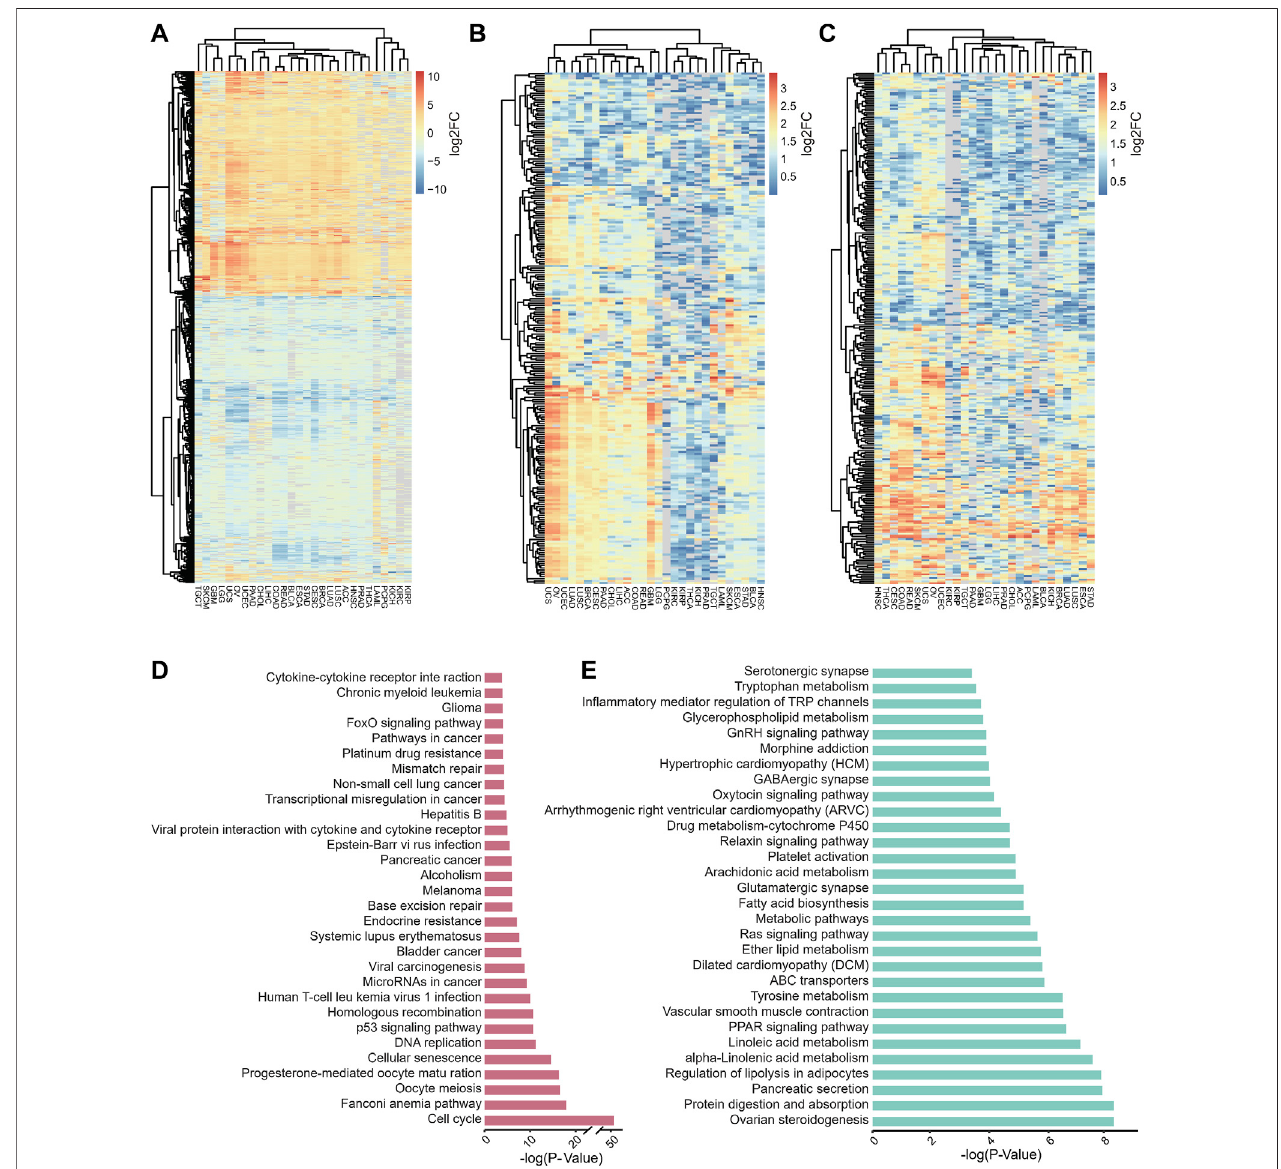
FIGURE 2 | Identi fi ed DEGs shared in more than 80% of cancers and pathways signi fi cantly associated with these DEGs. (A – C) Overview of identi fi ed DEGs (A) , identicalup-regulated (B) anddown-regulated (C) DEGssharedbyover80%oftumorsin28tumors. (D – E) Barplotrepresentsthetop30enrichedpathwaysofidentical up-regulated (D) and identical down-regulated (E) of DEGs that are shared by over 80% of tumors, analysis was performed using KOBAS 3.0.